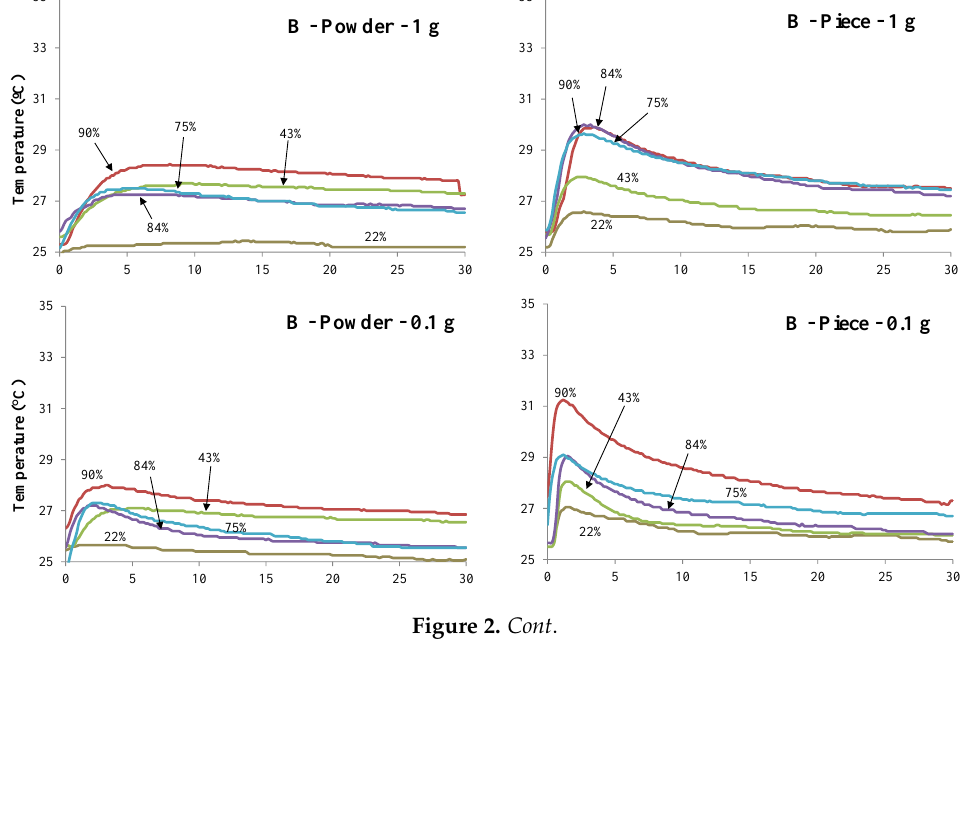
Q p - P i ece - 1 g Figure 2. Cont